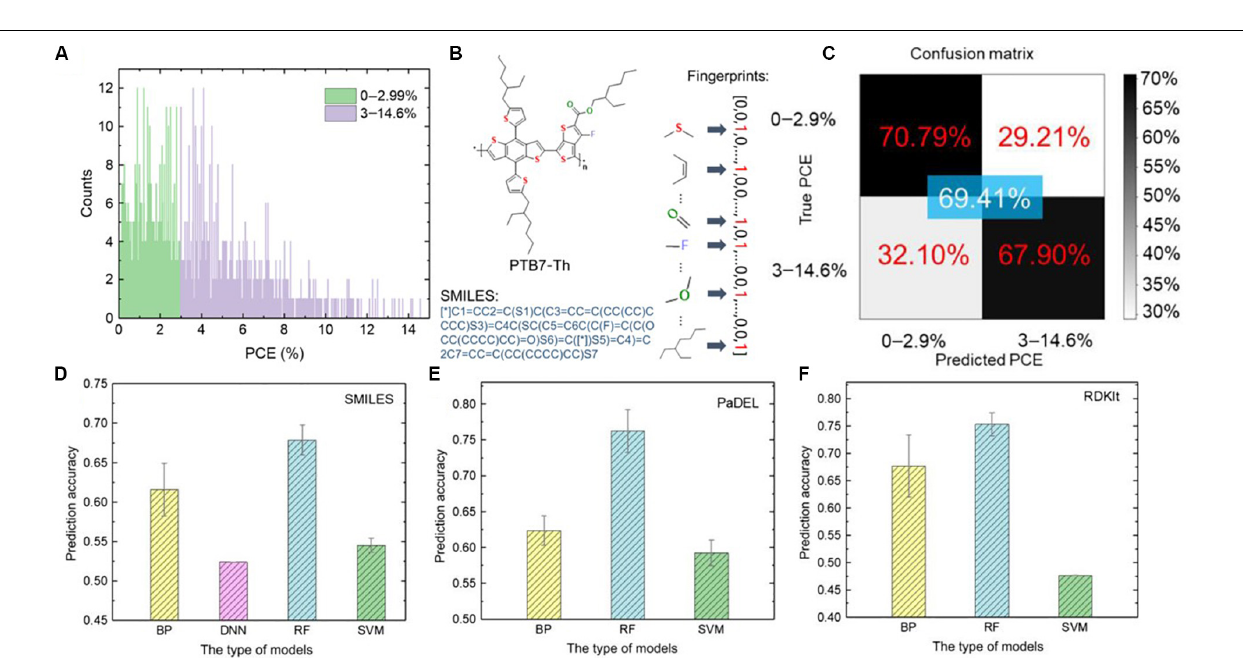
FIGURE 3 | Classification of molecular modeling methods and its applications in the field of catalysis.